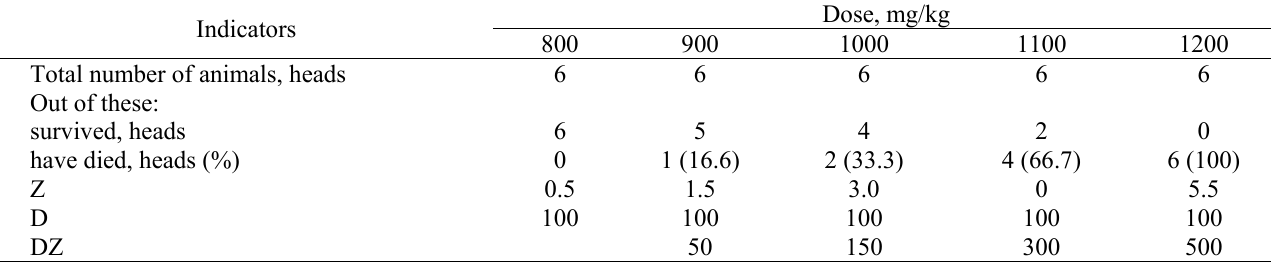
Determination of the average lethal dose of the drug “Zoоdizin” in male rats